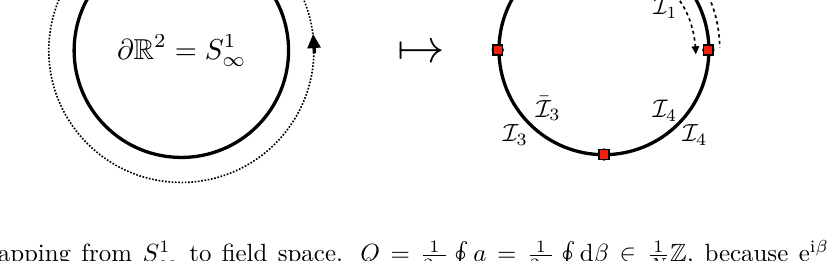
to field space. Q = 1 ∞ 3 model. CP